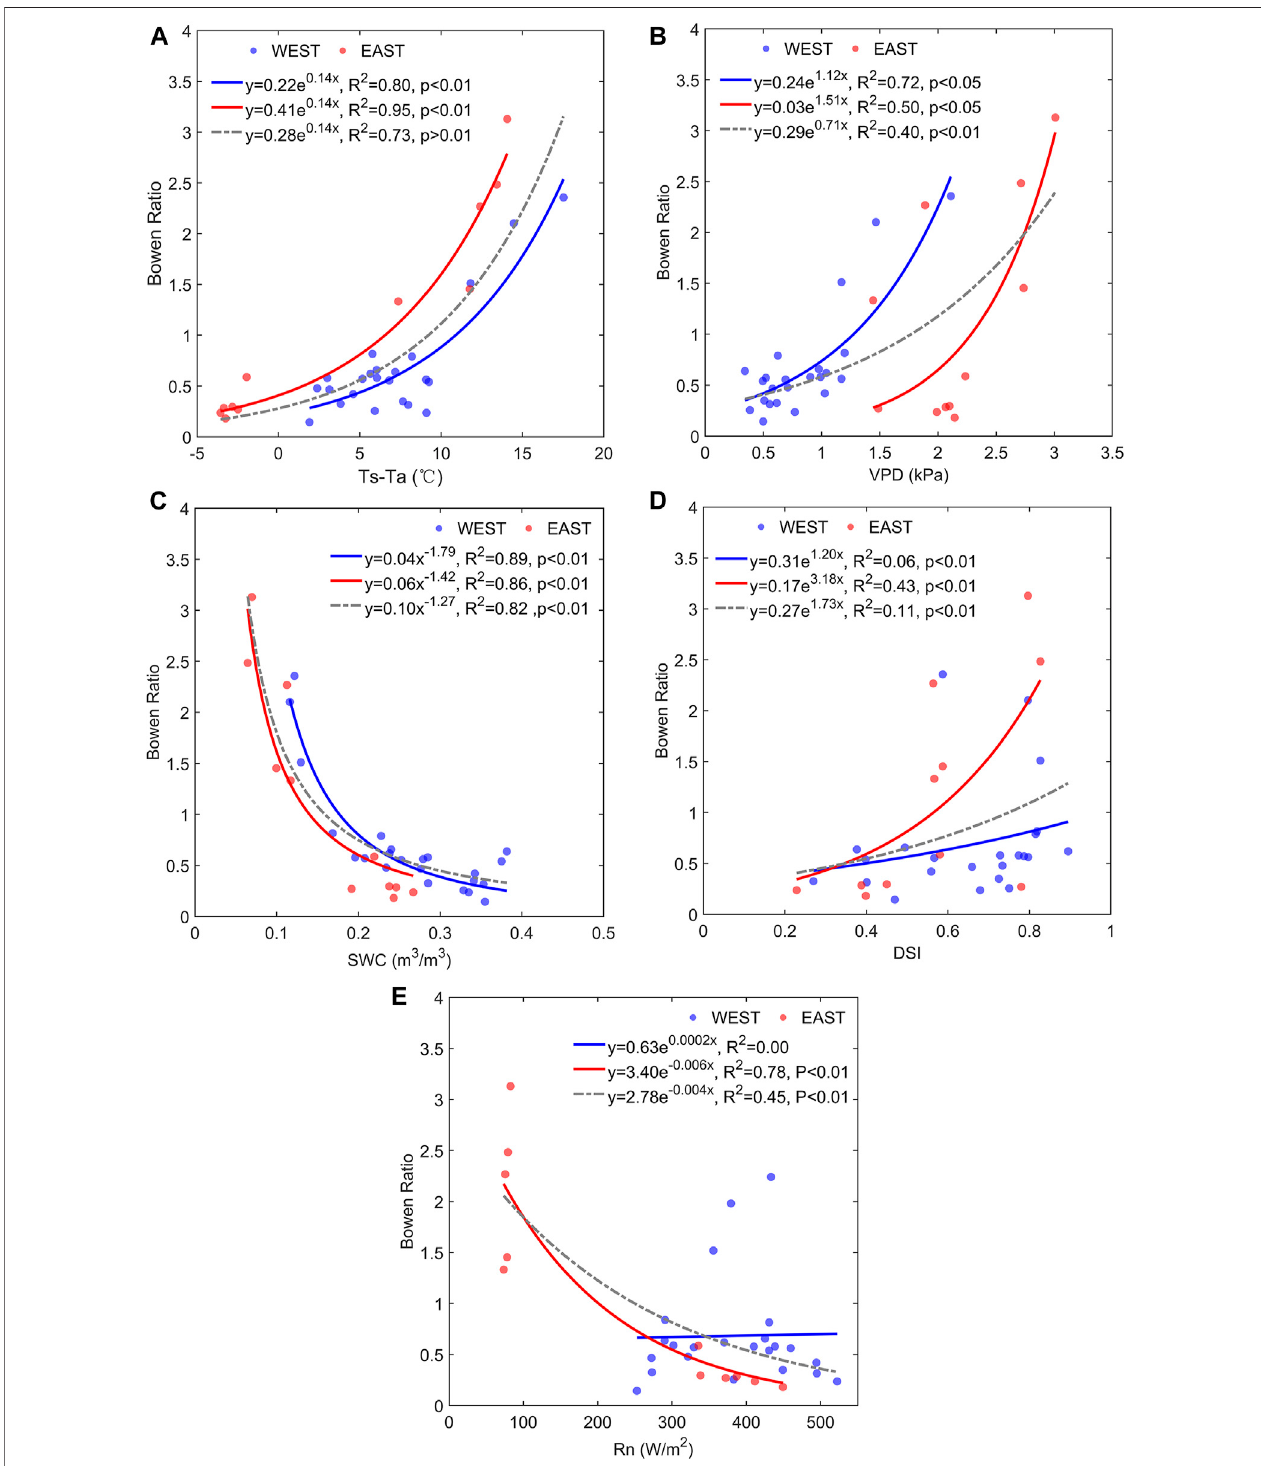
FIGURE 7 | Relationships between environmental factors and the Bowen ratio in the western and eastern regions. The blue (western) and red (eastern) solid lines shows the relationships between the Bowen ratio and (A) soil temperature minus air temperature ( Ts-Ta ), (B) vapor pressure de fi cit ( VPD ), (C) soil water content ( SWC ), (D) drought stress index ( DSI ), (E) net radiation ( R n ). The gray dotted lines represent the overall trends in the above relationships.